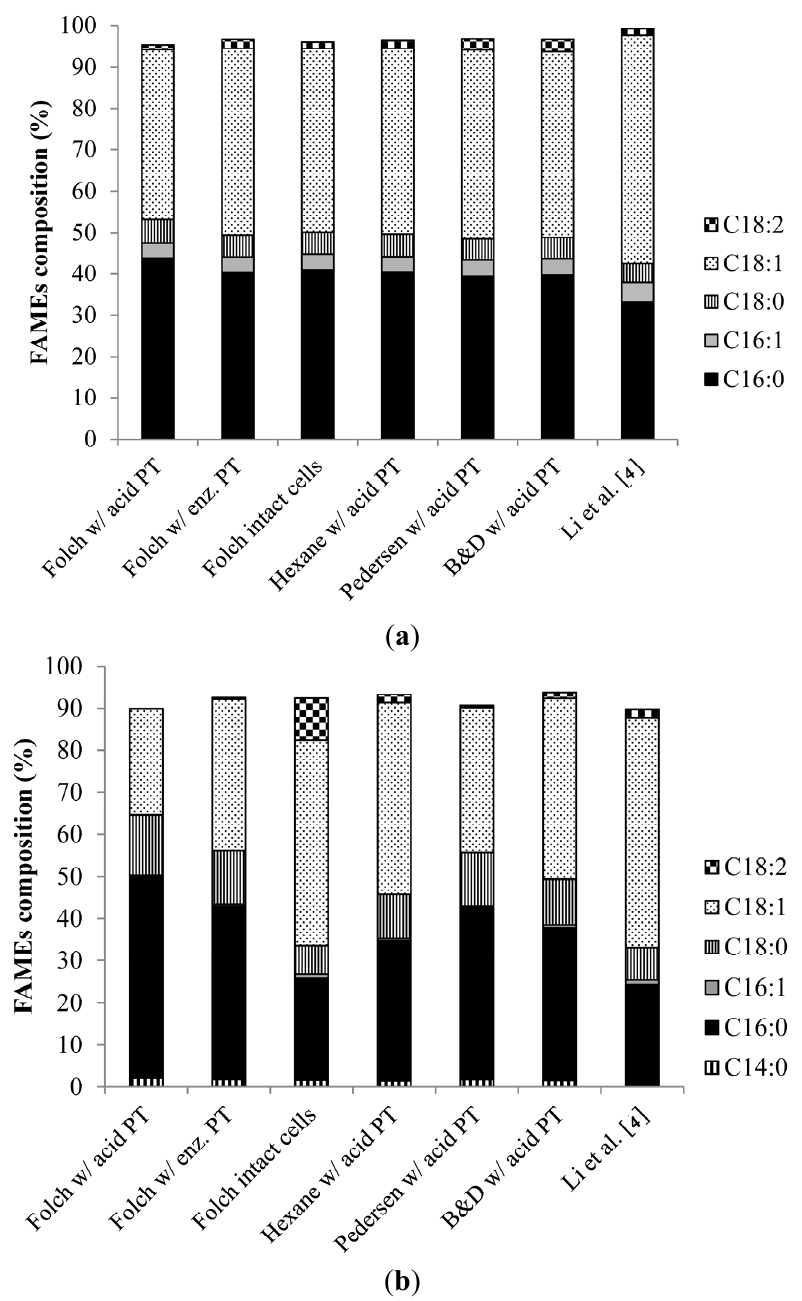
Figure 1. Comparison of the FAME compositions of lipids obtained with different extraction methods and pretreatments and values from the literature for ( a ) R. toruloides and ( b ) L. starkeyi . Only FAME contents above 1% were considered. PT: pretreatment; B&D: Bligh and Dyer; enz: